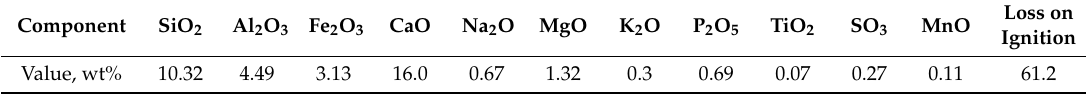
Table 2. The composition of inorganic substance in